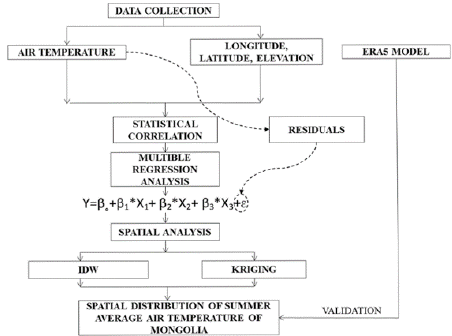
Figure 2. General scheme of research